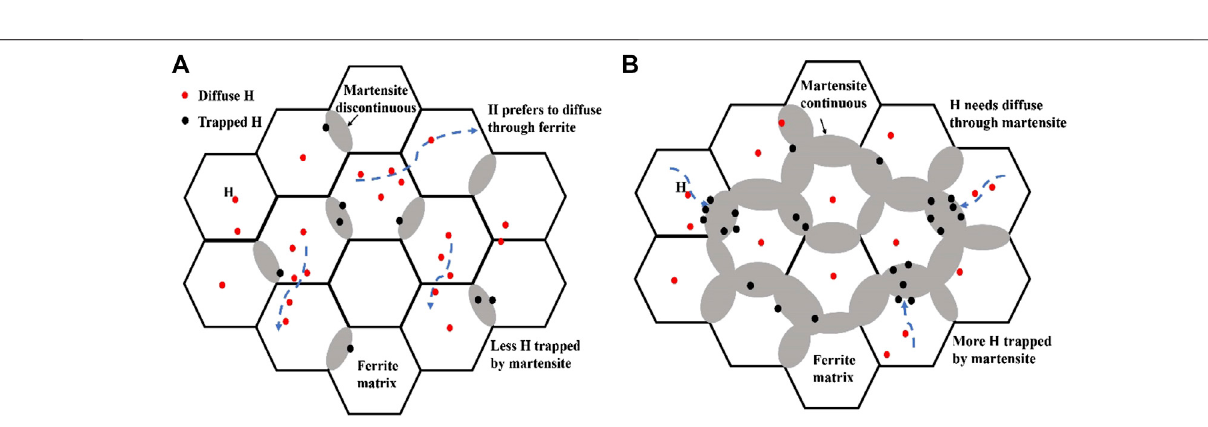
Frontiers in Materials |